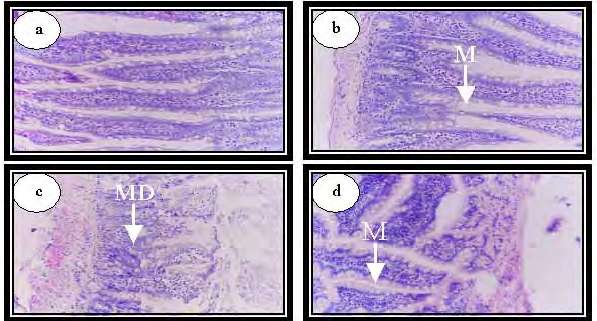
Figure 8 : Histopathology of intestine from female rats treated with saline (a) showing showing apparently normal intestinal mucosa; AcAaIT (b) showing metaplasia (M) to goblet cells in the villus epithelium; AcMNPV (c) showing mucinous degeneration (MD); and SlNPV (d) showing mild